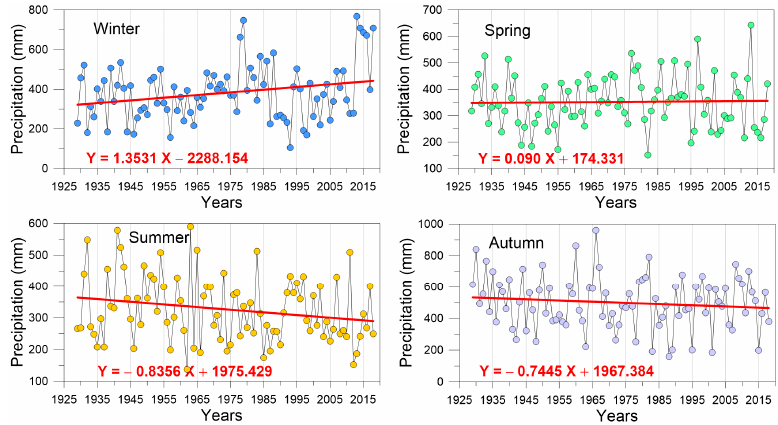
Figure 6. Representation of seasonal precipitation series with regression lines.